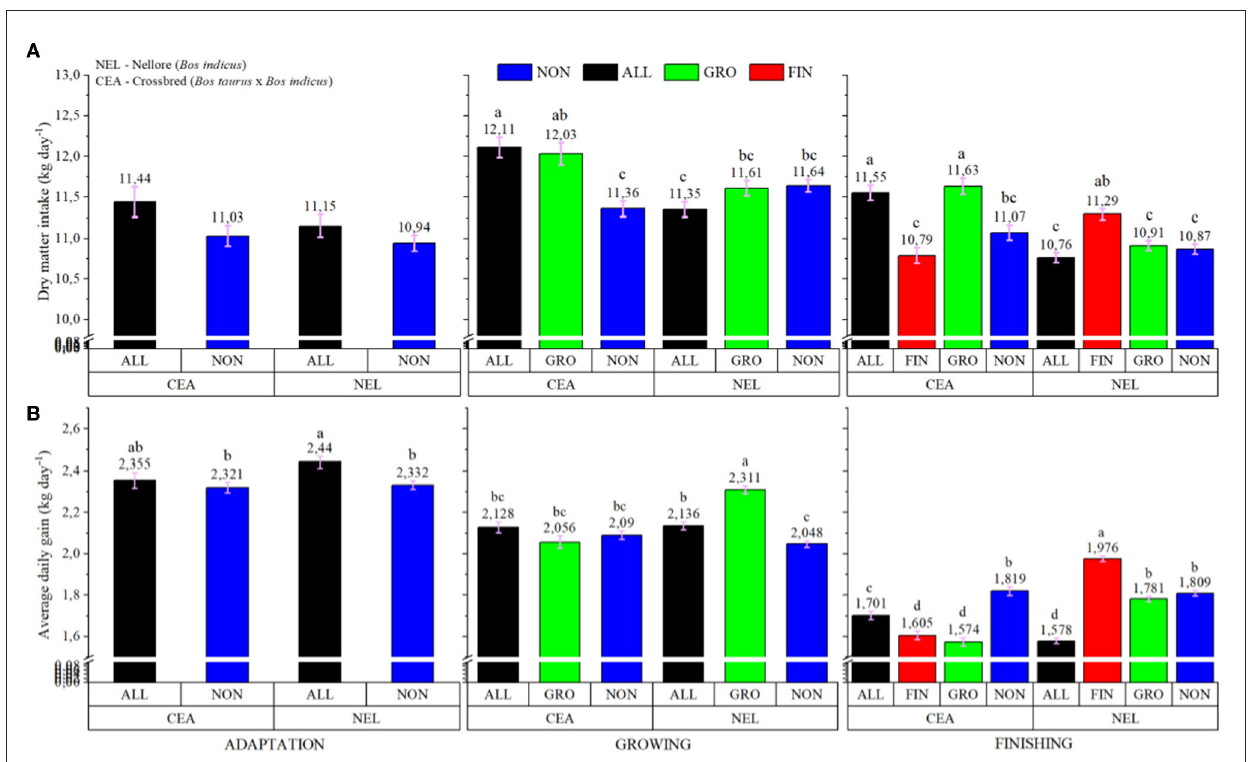
FIGURE1 Treatment × Breed × Feeding phase interaction of dry matter intake (A) and average daily gain (B) of electronically monitored Bos indicus influenced bullocks. NON, Control; ALL, Lysoforte supplementation in all phases (since adaptation); GRO, Lysoforte supplementation starting at growing phase; FIN, Lysoforte supplementation starting at finishing phase. CEA = ½ Nellore × ½ Angus, NEL = Nellore. Letters within column with different superscripts differ in LSMEANS at P ≤ 0.05.